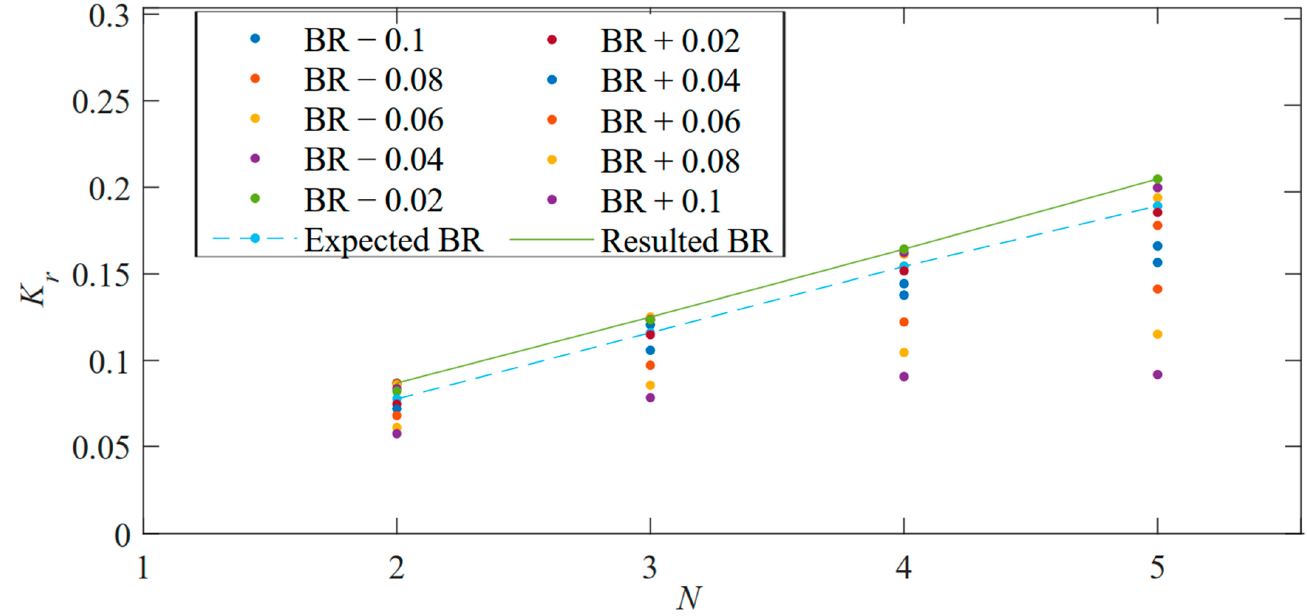
Figure 16. Bragg resonance of multiple periodically submerged breakwaters with 1.0 m wavelength at 0.4 m water depth.